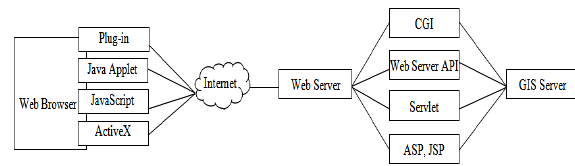
Figure 2: Thick client achitecture (adapted from Alesheikh et al. ,